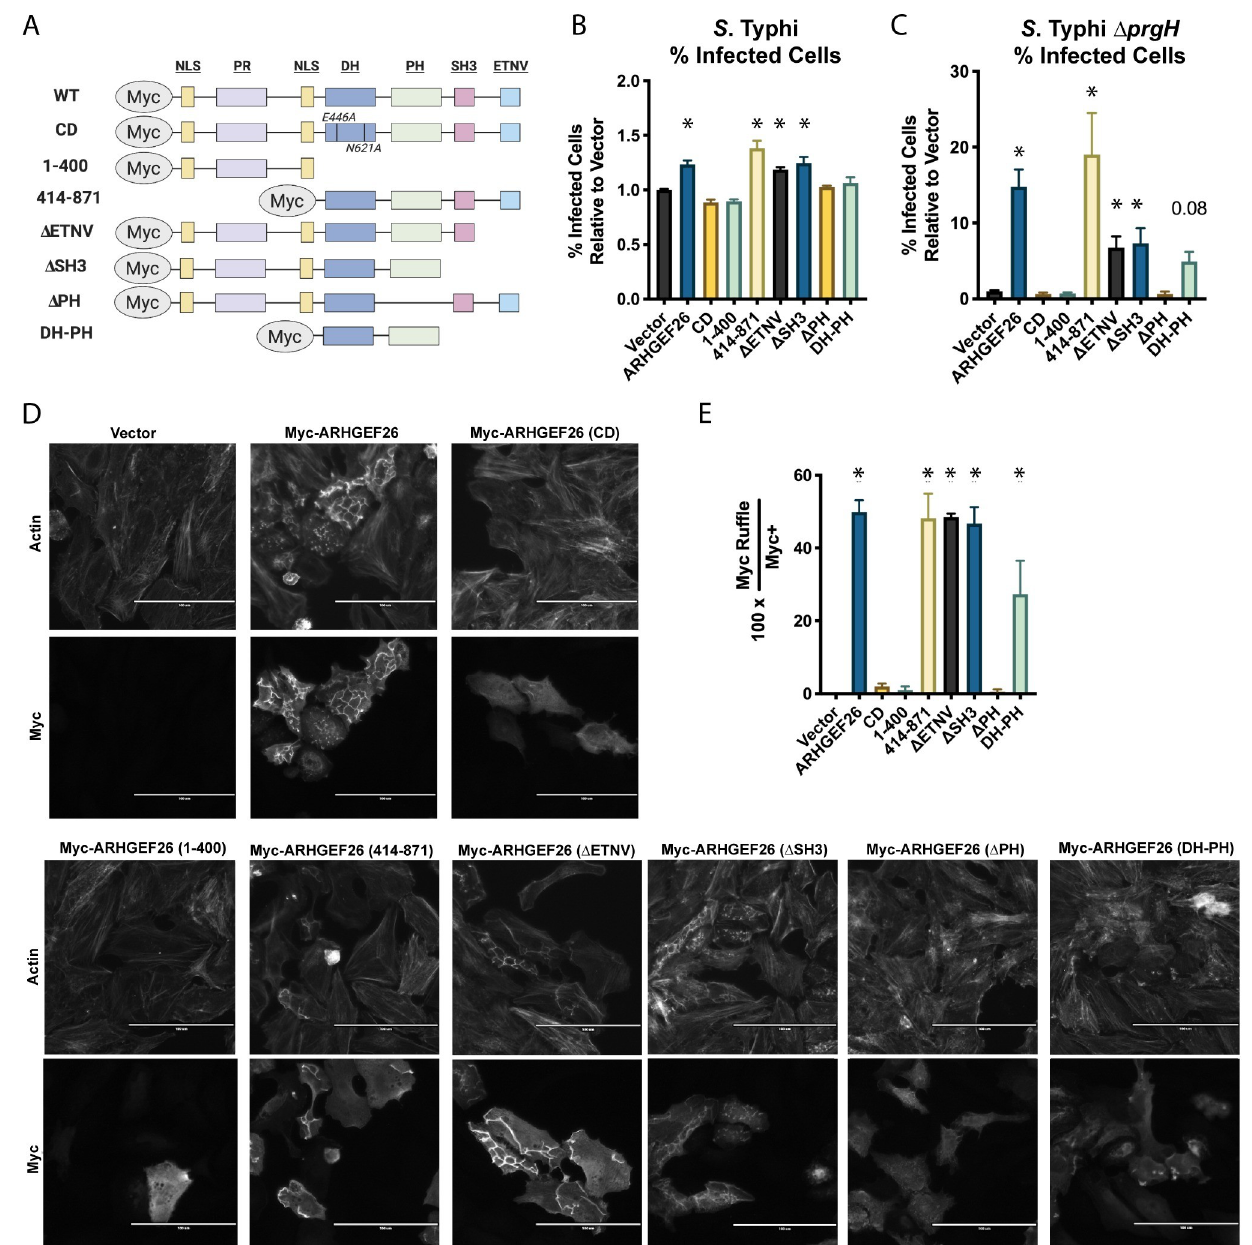
Fig 5. ARHGEF26 DH and PH domains are required for ARHEGEF26 to induce membrane ruffling and promote Salmonella HeLa cell invasion. (A) Schematic of overexpression constructs used. (B,C) Overexpression of ARHGEF26 constructs in HeLa cells results in increased wild-type S . Typhi infection (B), as well as infection by a SPI-1 secretion mutant ( Δ prgH ) S . Typhi (C). Infections were performed at MOI 30 for 60 minutes before gentamicin treatment and quantified 3 hours post infection by flow cytometry. % Infected Cells is reported relative to vector and includes data from at least three independent experiments with three replicates per experiment. Asterisk ( � ) represents a corrected p-value < 0.05 by Kruskal-Wallis test with Dunn’s multiple comparison test. (D) ARHGEF26 constructs able to induce invasion also induce membrane ruffling. Overexpression of catalytically active constructs in HeLa cells results in membrane ruffling that can be observed both with ARHGEF26 staining using the Myc Tag, as well as by using phalloidin staining to observe actin. (E) Quantification of membrane ruffling confirms correlation with ARHGEF26 -mediated invasion. Frequency of membrane ruffles was quantified as a percent of Myc+ cells that had a clear Myc+ ruffle. Ruffle abundance was quantified from four independent experiments. Values were generated by quantifying ruffles from five separate fields of view. The presence of a ruffle was confirmed by examining phalloidin stained actin at that site. Scale bar is 100 μ M. Asterisk ( � ) represents a corrected p-value < 0.05 generated by one-way ANOVA of the log(X+1) transformed values with Dunnett’s multiple comparisons test.